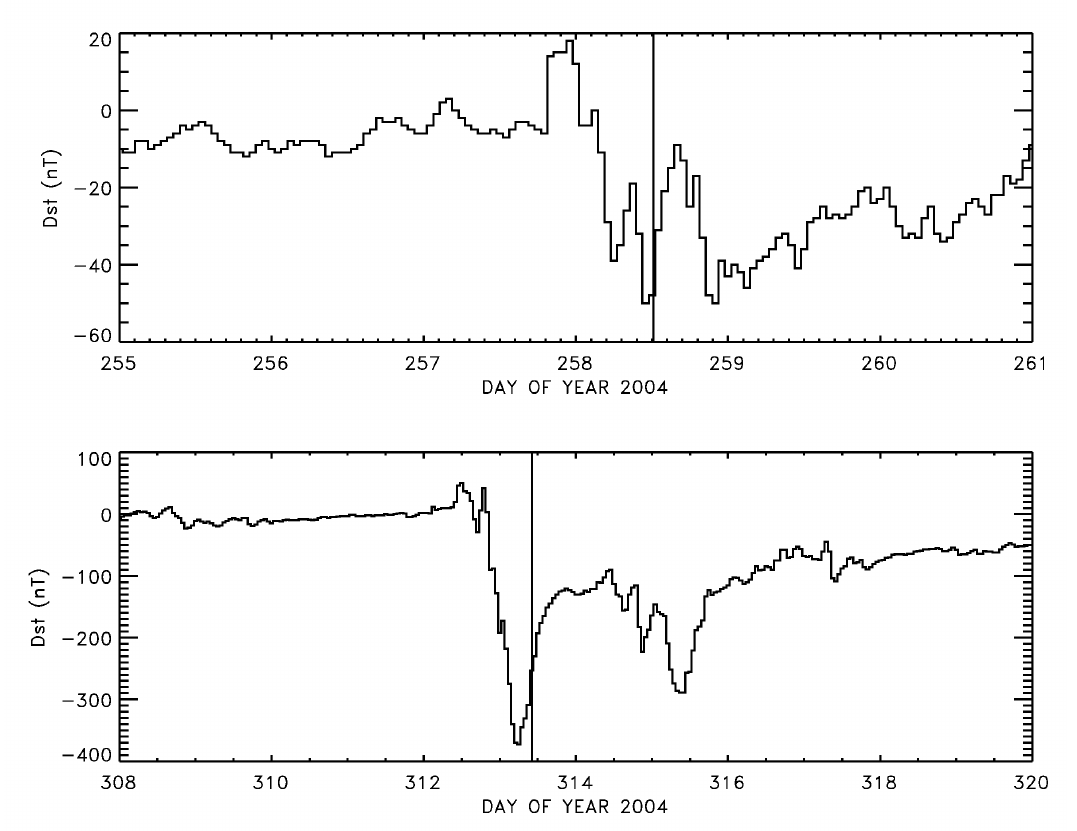
Fig. 12. Dst index covering the magnetic storms of September 2004 and November 2004. The vertical lines appearing on these records indicate times when the ENA images presented in Figs. 13 and 23 were